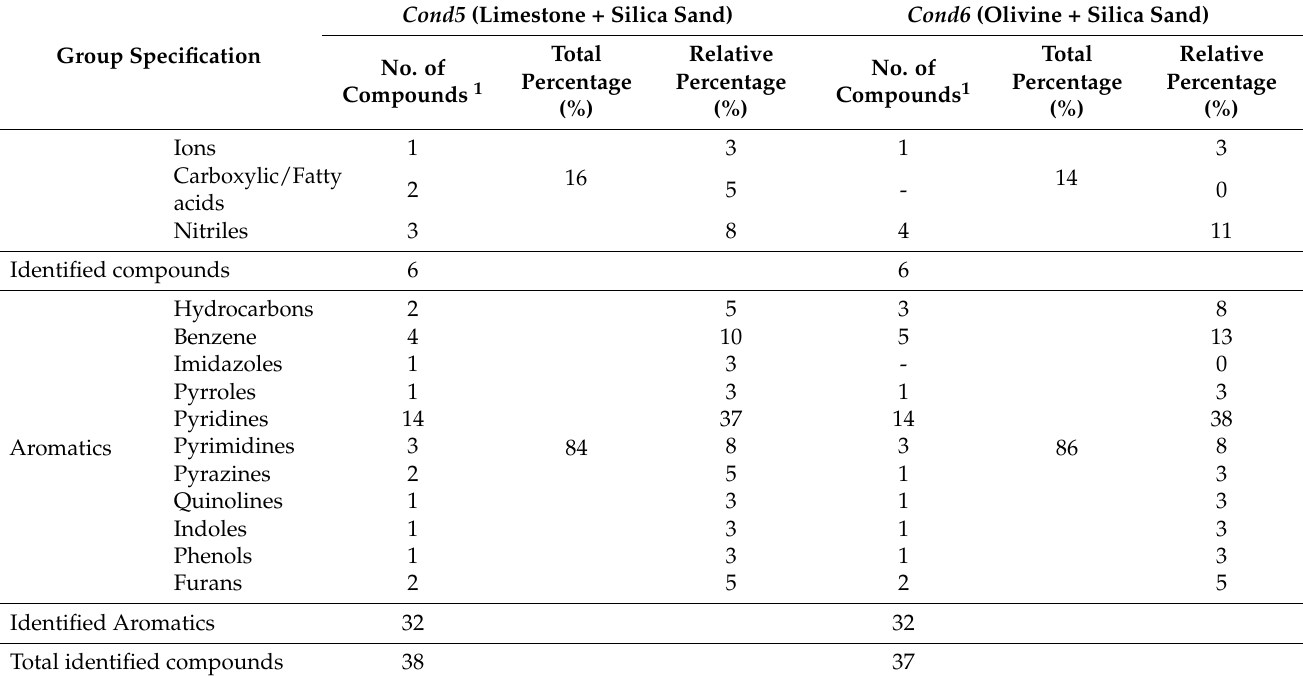
Table 5. Distribution by chemical group of the compounds identified by GC-MS in the condensates that were obtained by gasification of WST at 800 ◦ C in the presence of different catalysts. Cond5 and Cond6 gasification conditions are described in Table 2.